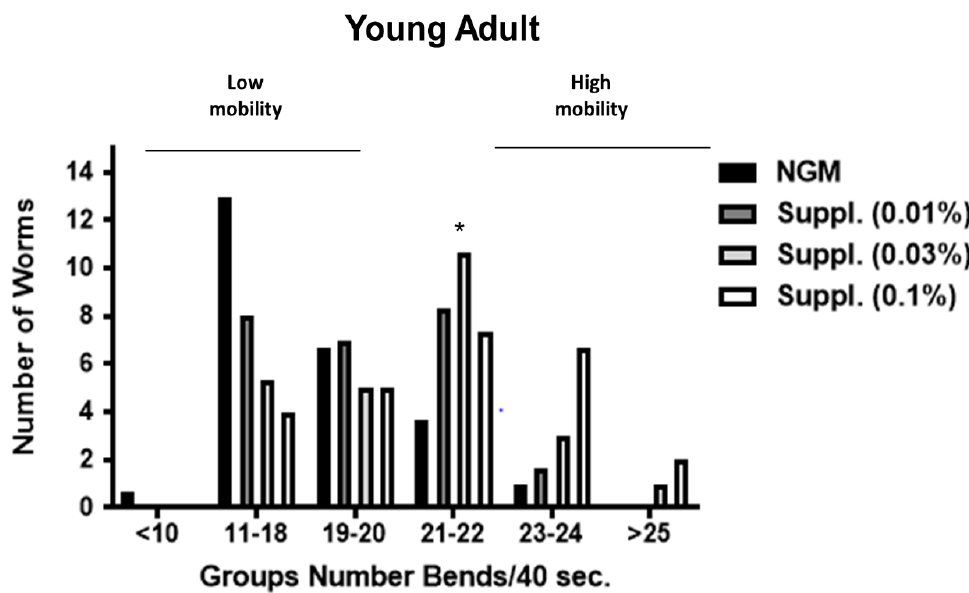
Figure 9. Distribution of mobility rate in Young adult (1-Day) worms used in the study. Different groups were established based on the speed (number of body bends / 40 s) of worms. One-way ANOVA was used to compare conditions within each group for number of body bends. * Significant p < 0.05 vs. NGM (within the group).